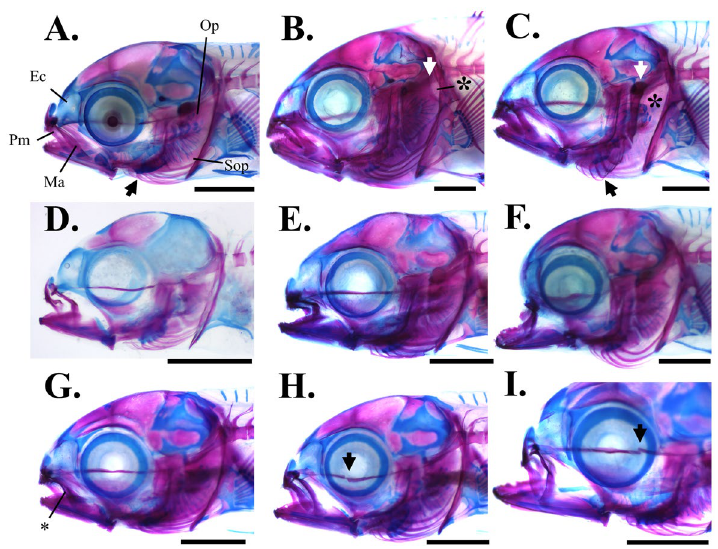
Figure 4. Variability of cranial abnormalities in the examined samples. ( A ) Normal. ( B–C ) gill-cover abnormality, light ( B ) and severe ( C ), with inward folding of the operculum (white arrow), sub-operculum and branchiostegal rays ( C , black arrow). Asterisks indicate the gill-chamber. ( D-E ) light ( D ) and severe ( E ) pugheadedness, associated with twisted maxillaries and pre-maxillaries. ( F ) Severe pugheadedness, with lack of pre-maxillaries, malformed maxillaries, ethmoid cartilage and lower jaw. ( G ) Fusion (*) between the maxillary and pre-maxillary bones. ( H–I ) Pugheadedness, associated with the fracture of the parasphenoid-vomer bar (arrows). Ec, ethmoid cartilage. Ma, maxillary. Op, operculum. Pm, pre-maxillary. Sop, sub-operculum. Scale bars equal to 1